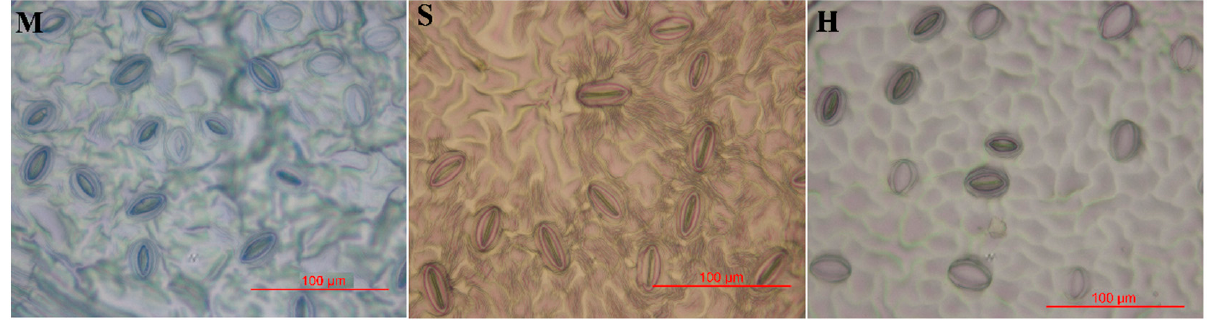
Figure 2. Leaf stomatal morphology of three peach rootstocks after 14 d of waterlogging (Bar = 100 µ m). Abbreviations: M: Prunus persica, ‘Maotao’; S: Prunus davidiana, ‘Shantao’; H: ‘Hossu’.